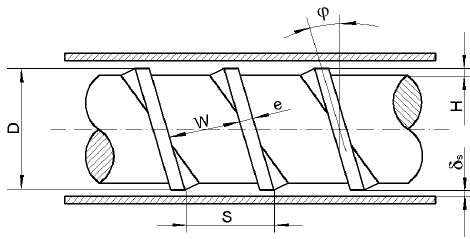
Figure 1. Geometry of the screw-barrel system of the injection screw machine.